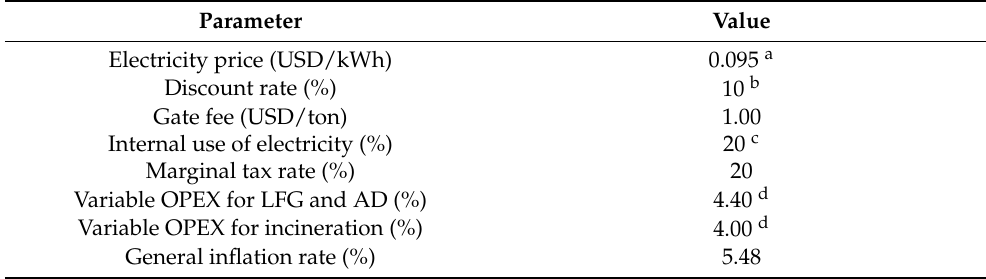
Table 3. Input parameters for economic